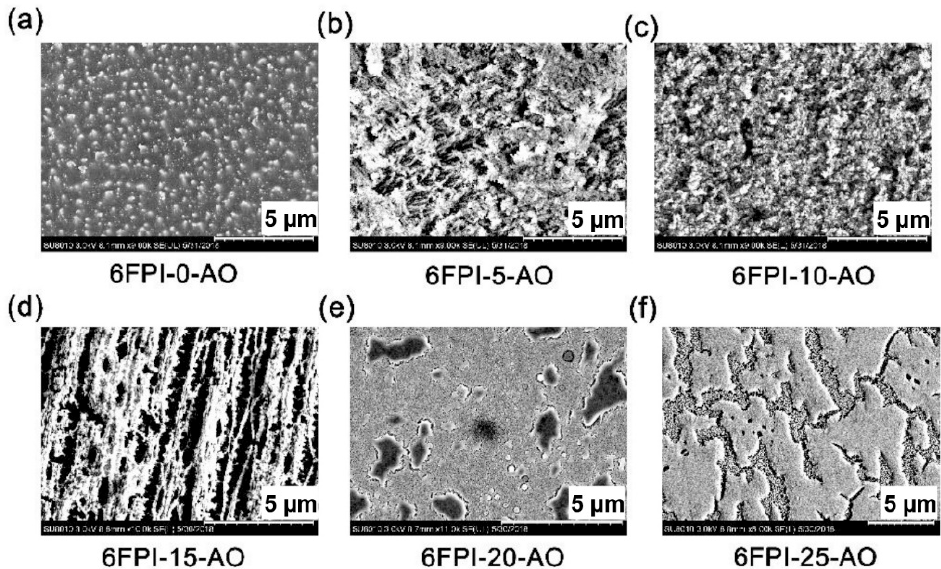
Figure 16. SEM images of 6FPI-X-AO films after AO exposure. ( a ) 6FPI-0-AO, ( b ) 6FPI-5-AO, ( c ) 6FPI-10-AO, ( d ) 6FPI-15-AO, ( e ) 6FPI-20-AO, ( f ) 6FPI-25-AO.